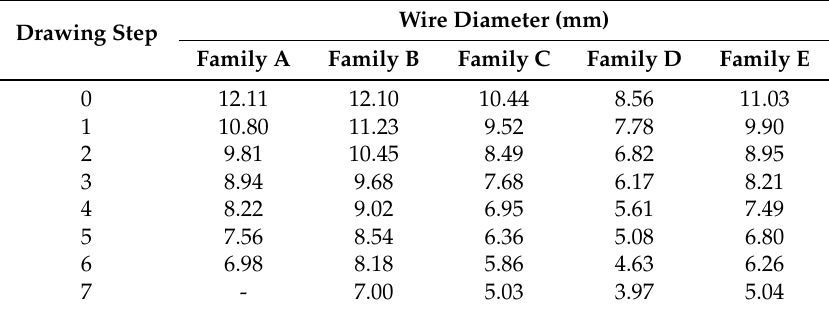
Table 2. Diameter of the wires at the end of each drawing step for the five families.